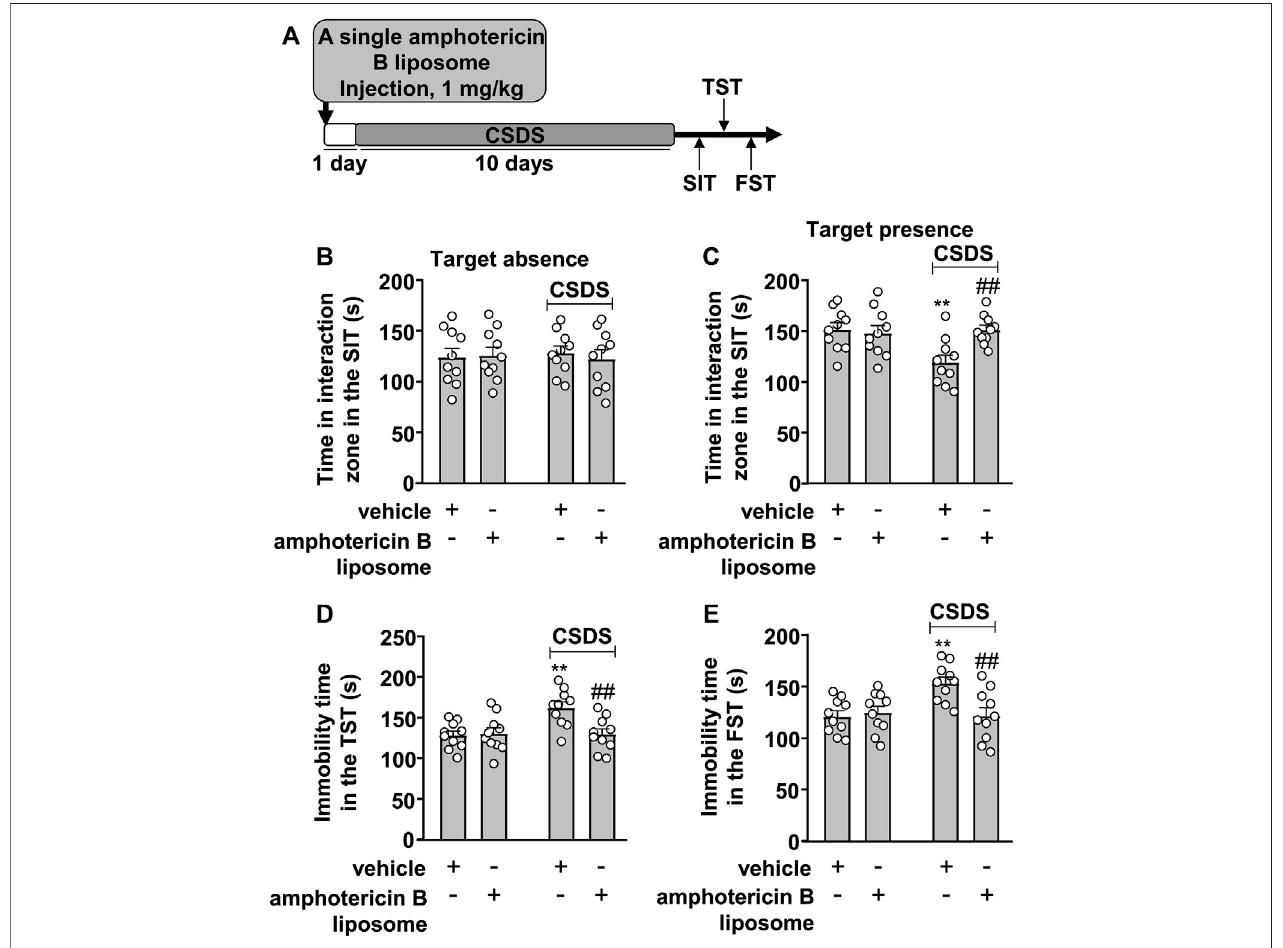
FIGURE 2 | Effect of pre-stress amphotericin B liposome administration on CSDS-induced behavioral abnormalities in mice. (A) schematic diagram showing the timecourse ofamphotericin Bliposome injection before stressexposure and behavioral testing instress-naïveandCSDSmice. (B – E) Quantitative analysisshowedthat a single injection of amphotericin B liposome (1 mg/kg) 1 day before stress exposure prevented the CSDS-induced decrease in the time spent in the interaction zone in the SIT (B,C) and the CSDS-induced increases in the immobility time in the TST (D) and FST (E) in mice (n = 10, pp p < 0.01 vs. vehicle, ## p < 0.01 vs. vehicle + CSDS). Data are shown as mean ±